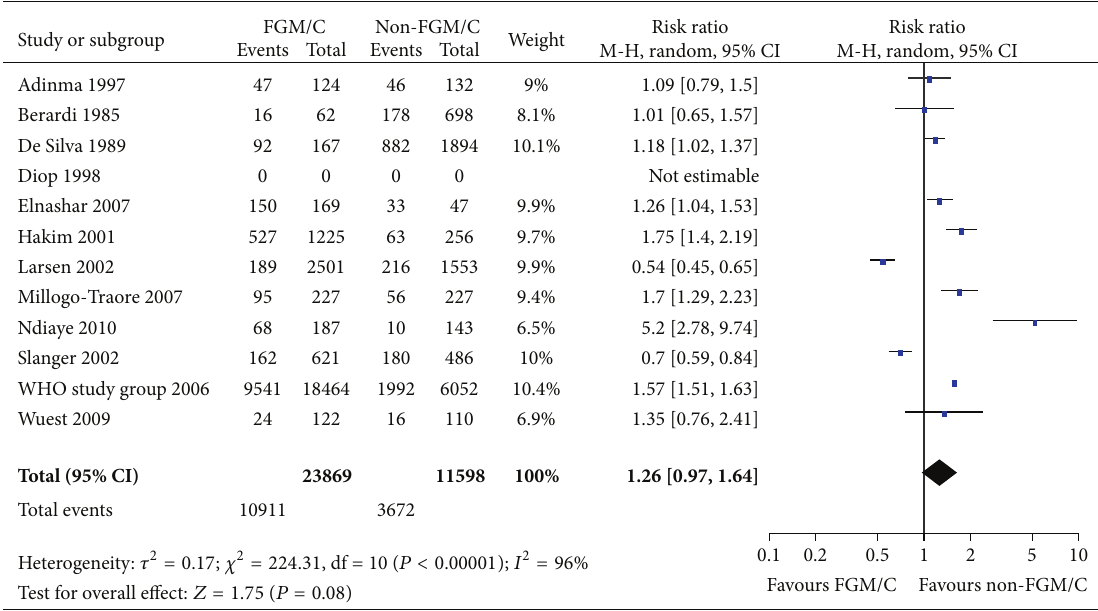
Figure 5: Forest plot, episiotomy. Note: Sensitivity analyses for parity were not statistically significant. Data were missing in Diop et al. [34], and we did not succeed in obtaining data from the authors; thus, results fromthis study are not estimable. WHO study group [19]: unpublished data.